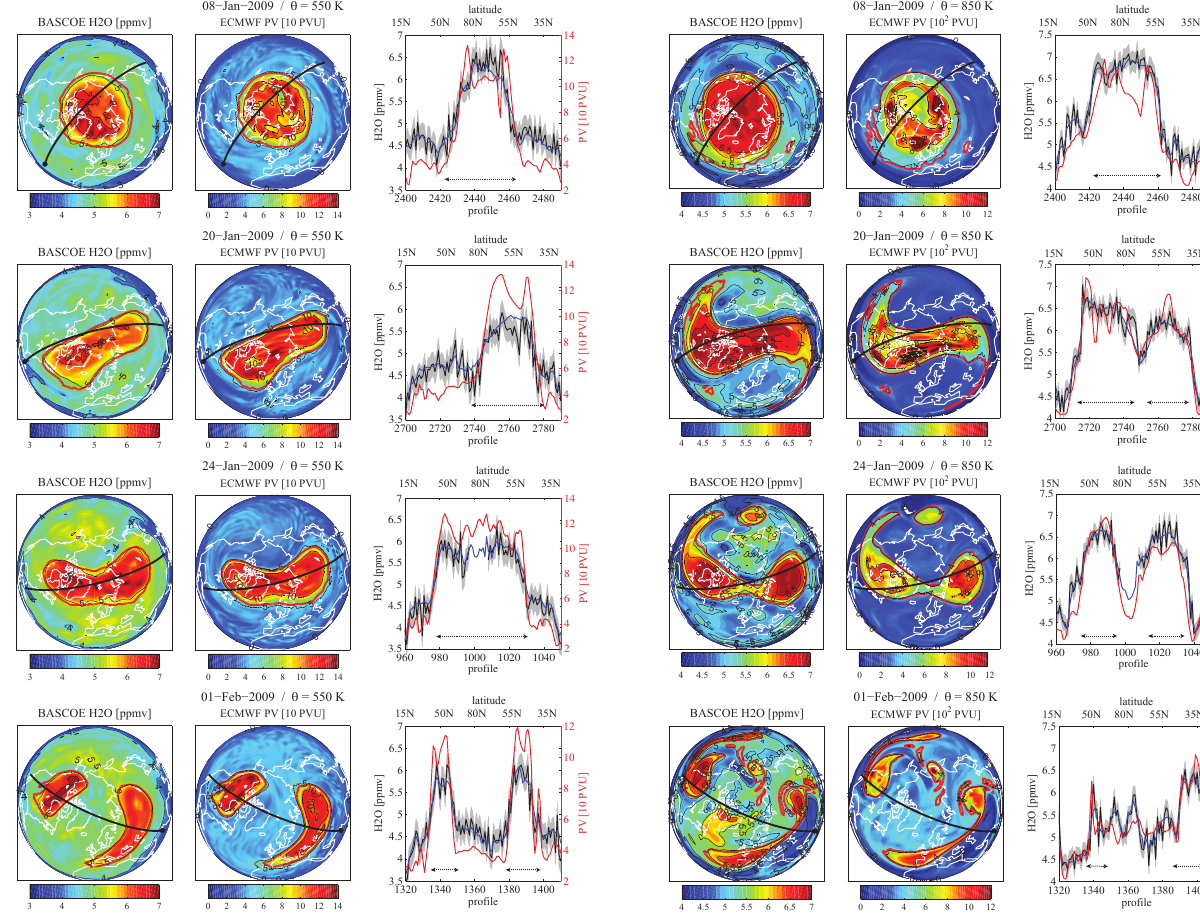
Fig. 4. Plots of geophysical quantities at 550K. (Left column) NH BASCOE water vapour analyses,ppmv; (Middle column) NH ECMWF PV field (10 × PV units); (Right column) MLS water vapour measurements (black line,ppmv; on orbits indicated), and BASCOE water vapour analyses (blue line, ppmv) and ECMWF PV fields (red line, 10 × PV units) interpolated to the orbits indi- cated in left and middle columns. On right column plot, orbit pro- file numbers are indicated at the bottom, and approximate latitudes are indicated at the top. Top row: 8 January 2009; second row: 20 January 2009; third row: 24 January 2009; bottom row: 1 Febru- ary 2009. In left and middle columns, red indicates relatively high values; blue indicates relatively low values; bold red contours indi- cate the vortex edge (see text for definition). In right column, grey indicates the 1-sigma precision in the MLS water vapour measure- ments. Dashed horizontal lines in the right column plots indicate regions of relatively high PV identified with the polar vortex.